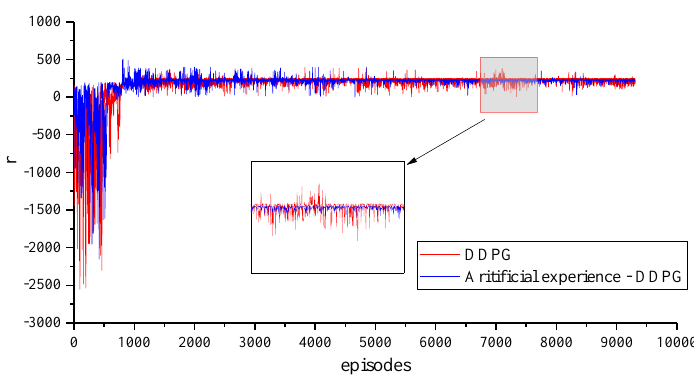
Figure 5. Accumulation of training reward value.